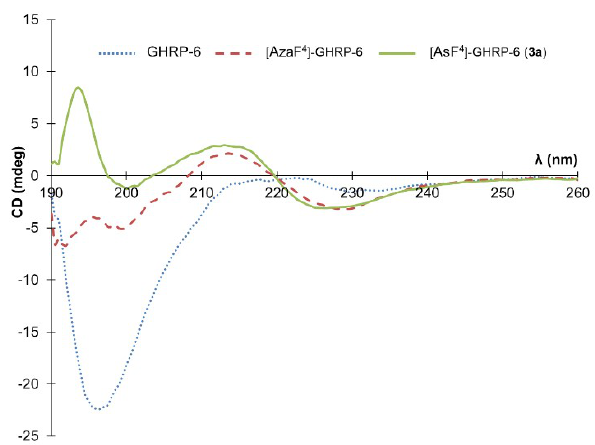
Figure 2. Circular dichroism spectra in water for GHRP-6 (blue dots), [AzaF 4 ]-GHRP-6 (red dashes) and [AsF 4 ]-GHRP-6 ( 3a , green solid line).